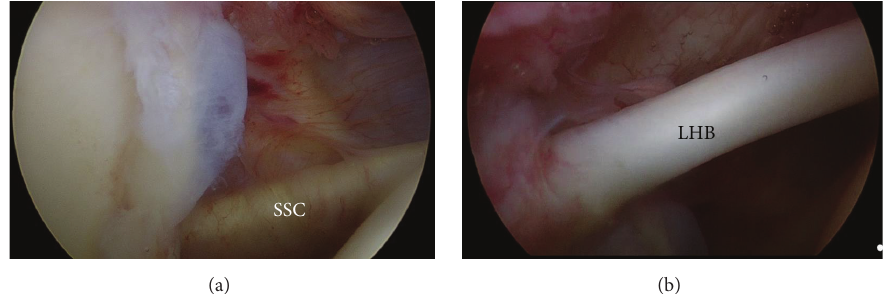
Figure 3: Arthroscopic findings in Case 3. (a) Synovial proliferation in the rotator interval and the superomedial capsule. (b) The CHL from the coracoid process to the LHB was thickened and